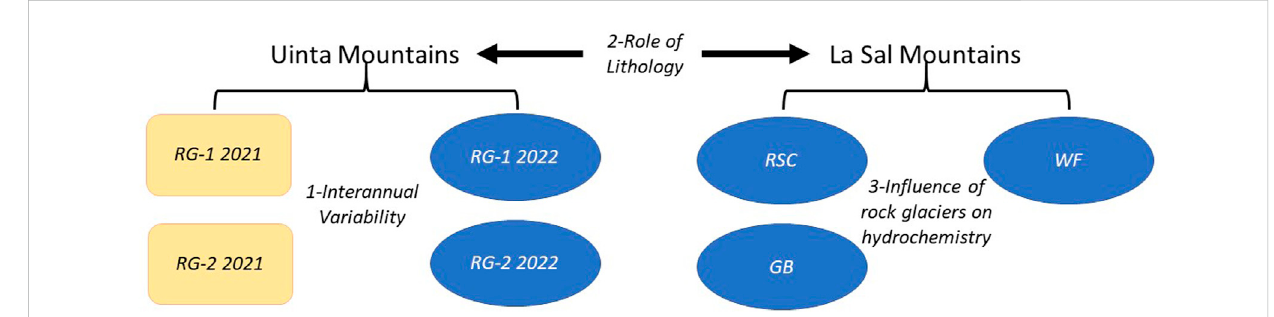
FIGURE 8 Schematic diagram illustrating how the time series of water samples collected in the Uinta and La Sal Mountains are used to address 3 complementary questions. The interannual consistency of the hydrochemistry of rock glacier water can be addressed using the data presented here from RG-1 and RG-2 along with data from these same sites collected in 2021 (Munroe and Handwerger, 2022). The role of lithology is addressed by comparing the data from the quartzite-dominated Uinta Mountains with the trachyte-dominated La Sal Mountains. The impact of rock glaciers on the overall hydrochemistry of a catchment can be studied in the La Sal Mountains where the RSC and GB time series are from a rock-glacierized watershed, and the WF sampler is from a watershed lacking rock glaciers.